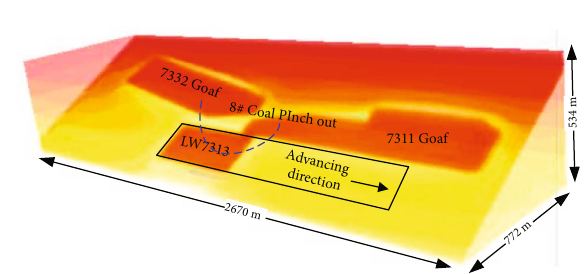
Figure 11: Model